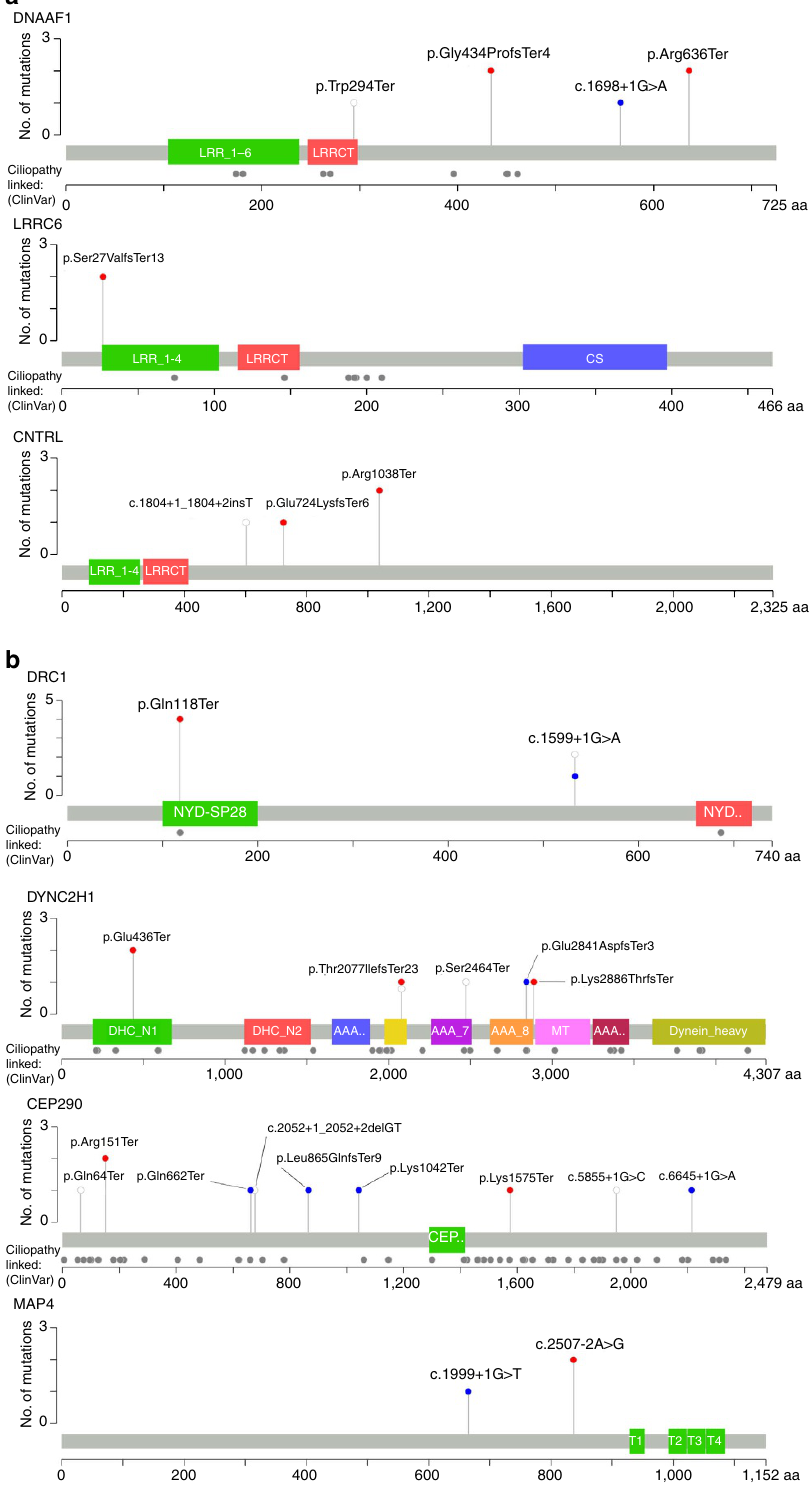
Figure 2 | Disruptive germline mutations in cilia-microtubule pathway genes identified in TGCT cases. ( a ) DNAAF1 and paralogue genes; ( b ) cilia-microtubule gene set. Red dots denote mutations identified in familial TGCTcases, blue dots denote mutations in unselected TGCTcases and white dots denote mutations in UK controls. Grey dots denote mutations catalogued by ClinVar 24 as a cause of recessive ciliopathy. Domain abbreviations: LRR, leucine-rich repeat; LRRCT, leucine-rich repeat C-terminal; CS, CHORD-containing proteins and SGT1; NYD-SP28, NYD-SP28 sperm tail; NYD.., NYD-SP28_assoc sperm tail C-terminal domain; DHC_N1, dynein heavy chain, N-terminal region 1; DHC_N2, dynein heavy chain; N-terminal region 1, AAA.., hydrolytic ATP-binding site of dynein motor region D1; AAA_7, P-loop containing dynein motor region D3; AAA_8, P-loop containing dynein motor region D4; MT, microtubule-binding stalk of dynein motor; Dynein_heavy pfama, dynein heavy chain and region D6 of dynein motor; CEP.., coiled-coil region of centrosome protein; M1-4, Tau/MAP